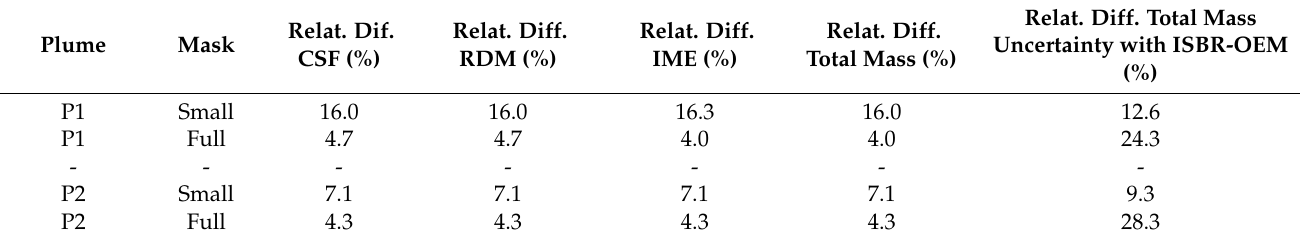
Table 6. Relative differences between results obtained with the ISB-OEM and the LM.